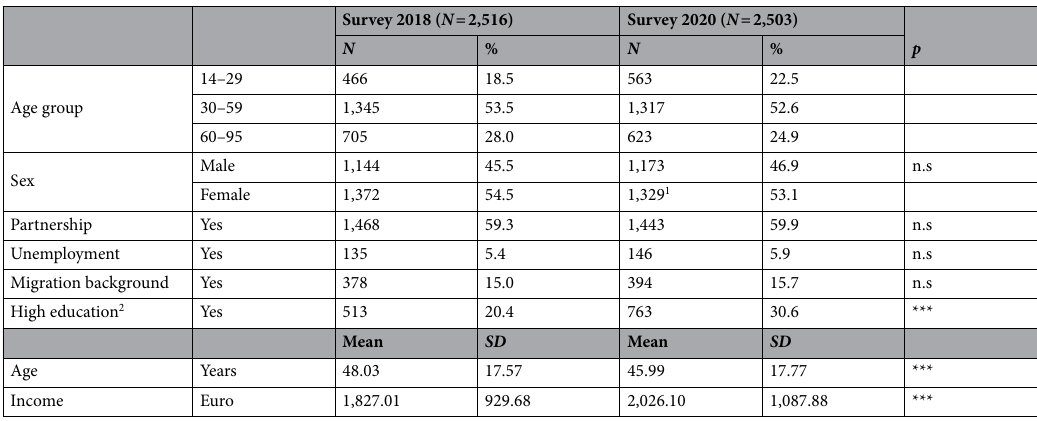
Table 3. Study participants of the surveys 2018 and 2020. 1 : N = 1 diverse; 2 : at least high school diploma; * p < 0.05, ** p < 0.01, *** p <